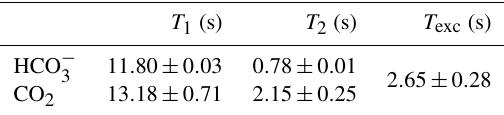
Table 4. Relaxation and exchange time constants for bicarbonate and carbon dioxide during OCV. Experiments were conducted after the initial 12h OCV